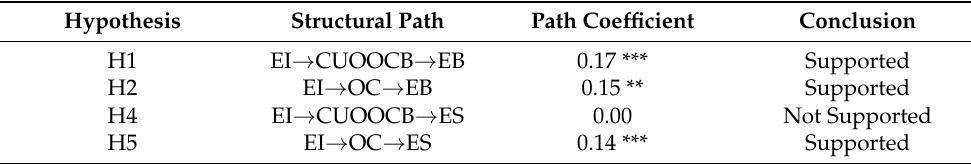
Table 6. Hypothesis testing and path coefficient (indirect influences).